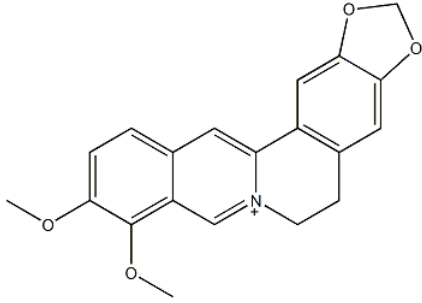
Figure 1. Molecular structure of berberine.